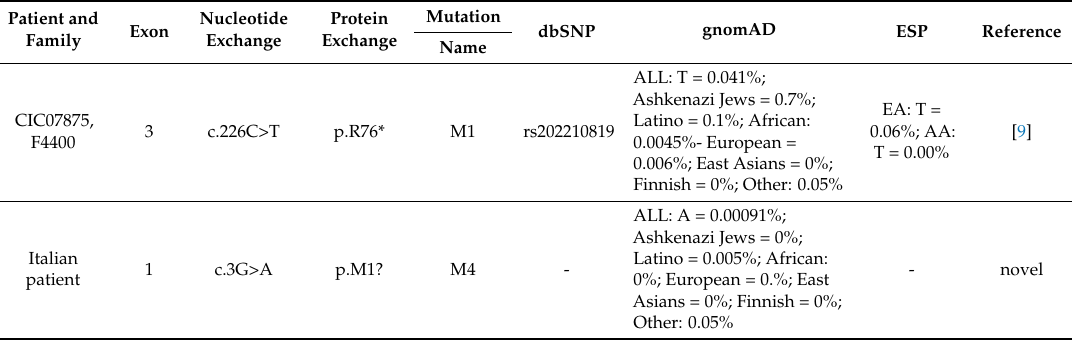
Table 1. Novel patients with rod-cone dystrophy and KIZ mutations.